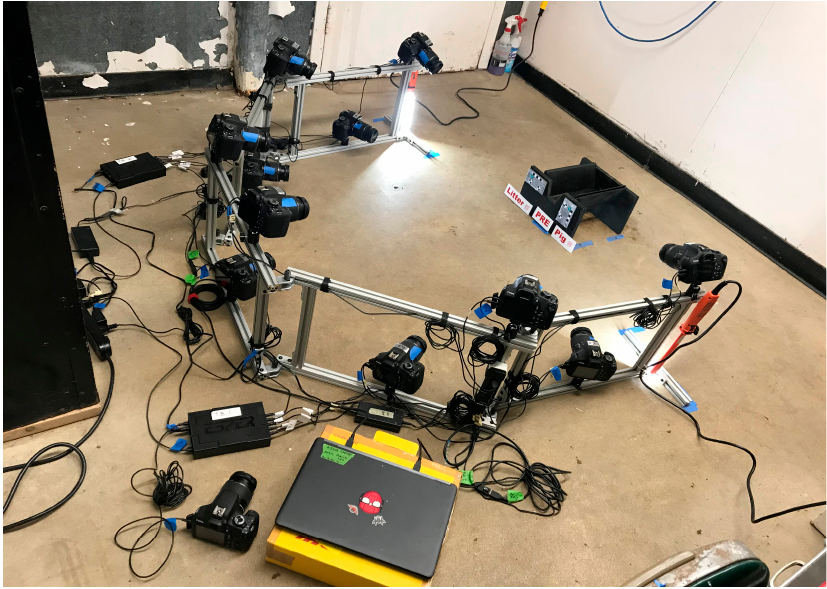
Figure 1. Photogrammetry rig and piglet